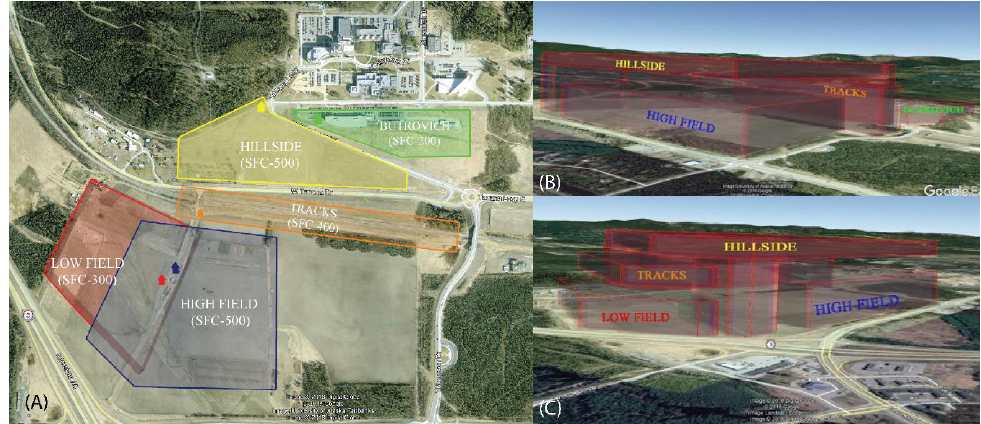
Figure 13. ( A ): Overhead view of baseline airspace volumes for UTM TCL3 and ( B , C ) 3D views of airspace.